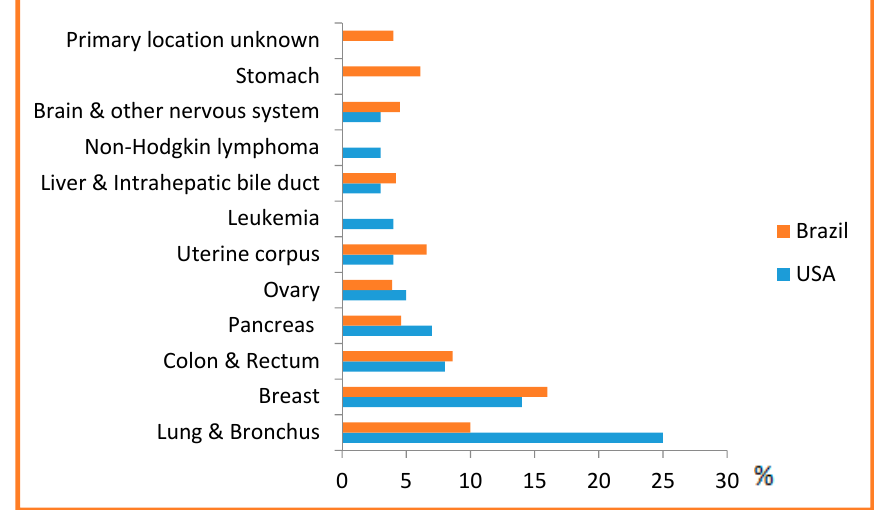
Figure 1. Top causes of cancer death, by sex in Brazil, 2008 [31] and the US [14]—Estimates for 2017. As estimates are rounded to more than ten cases, the exclusive cases of basal cells and squamous cells are skin cancers and carcinoma in situ, except for bladder urinary tract infection. Brazilian source: MS/SVS/DASIS/CGIAE/ Sistema de Informaç ã osobreMortalidade—SIM; MS/INCA/Conprev/ Divis ã o de Informaç ã o e an á lise de Situaç ã o. American Source: AMERICAN CANCER